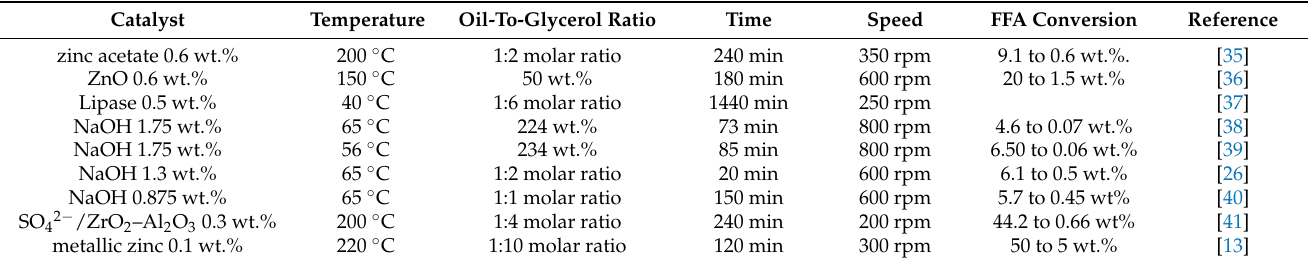
Table 1. A variety of parameter values, each of which was taken from a different publication.